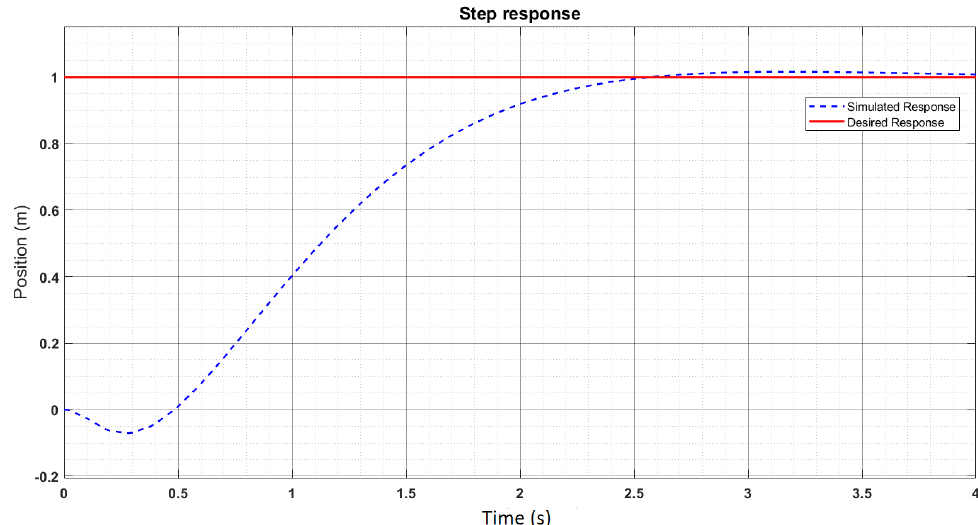
Figure 5. Step response for LQR control.